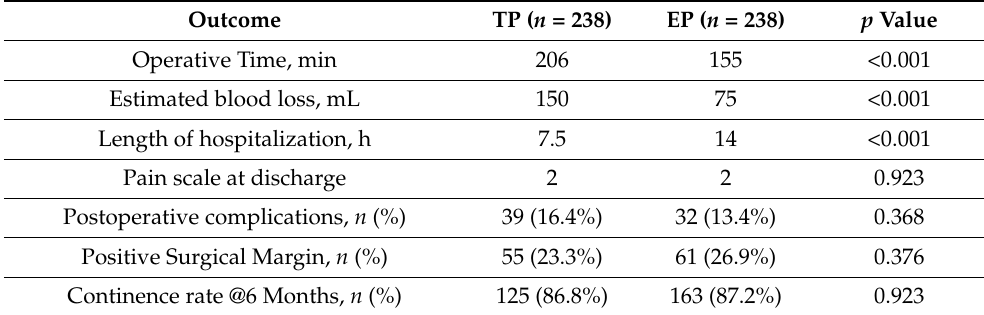
Table 2. Outcomes of transperitoneal versus extraperitoneal SP RALP (adapted from Abou Zeinab et al.